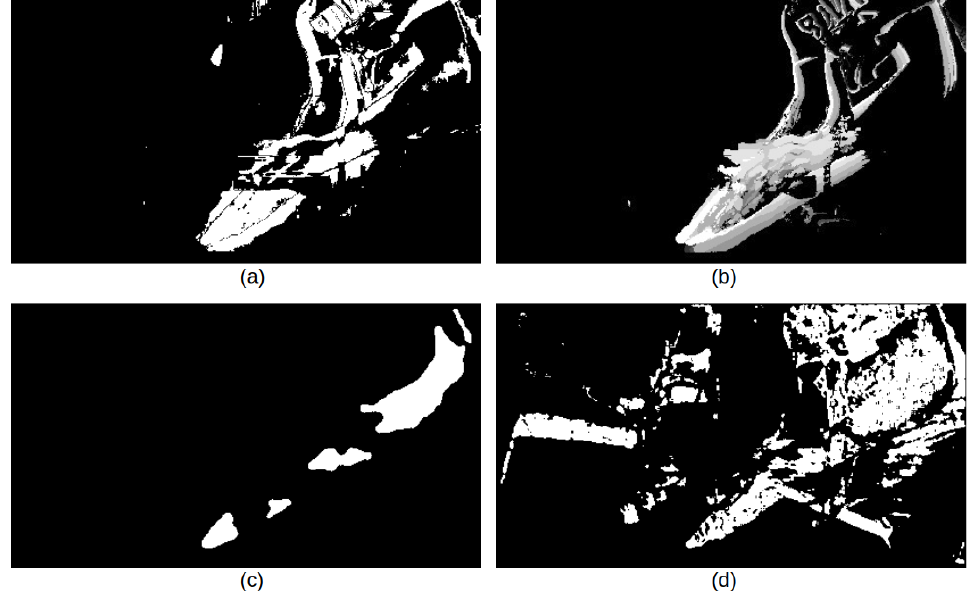
Figure 12. ( a ) Adaptive background learning [52]. ( b ) Motion history image. ( c ) Fuzzy Choquet integral [53]. ( d ) SuBSENSE [54].